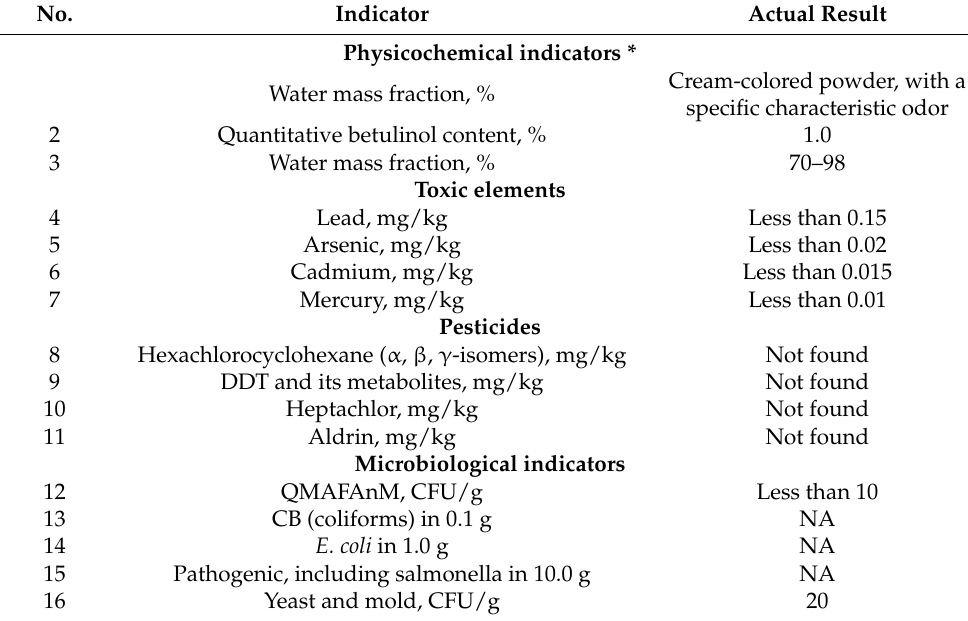
Table 3. The main extract characteristics.